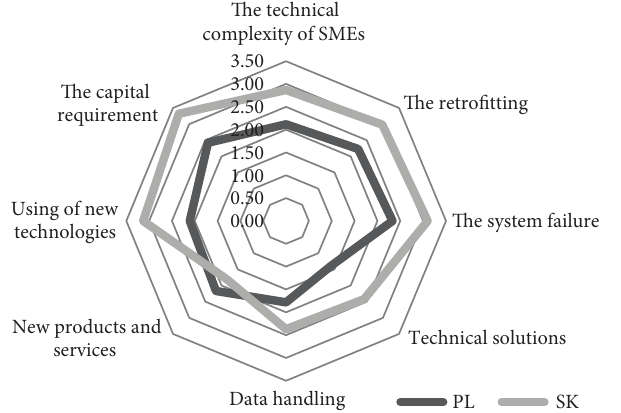
Figure 1. The overall perception of risks – average value of SMEs’